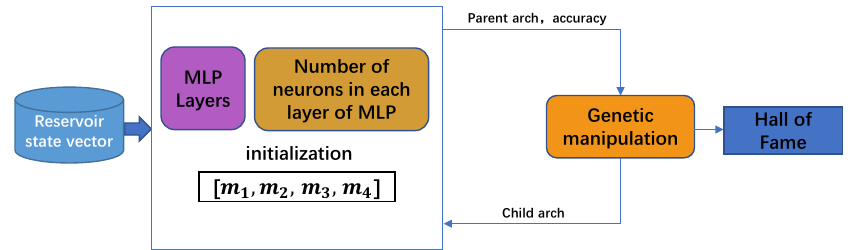
Figure 4. Exploration of classifier architecture based on